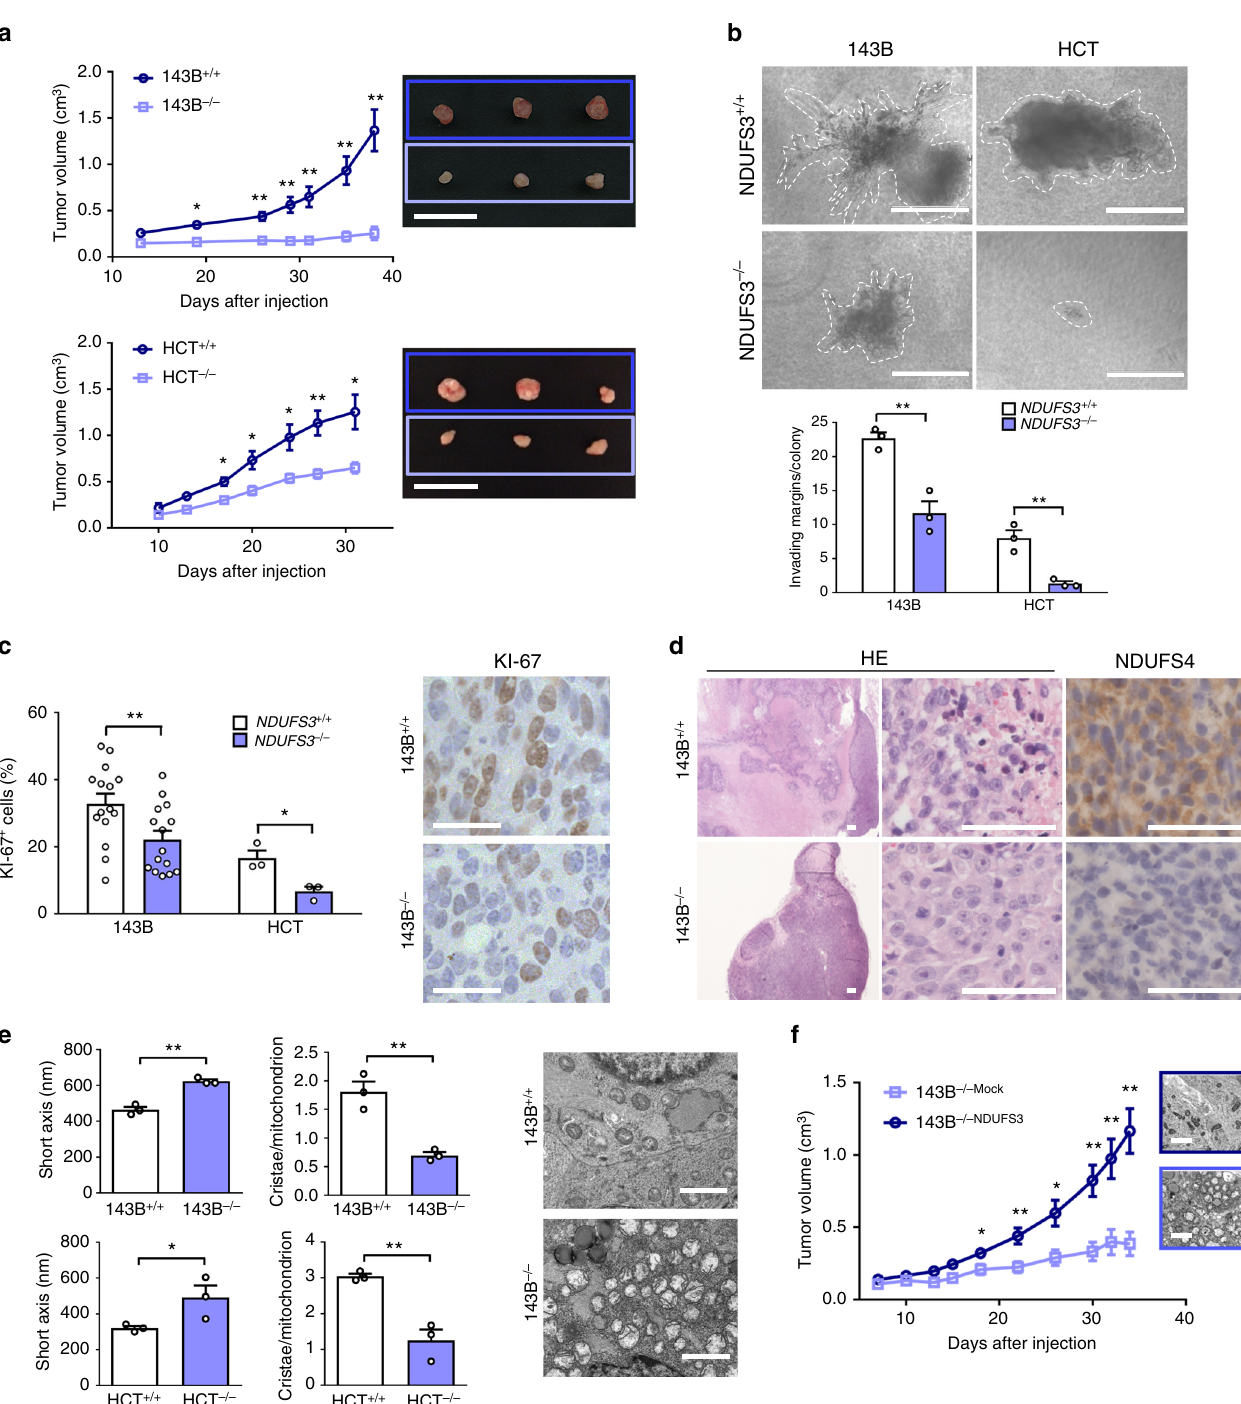
(143B − / − NDUFS3 ), under the control of a transactivator negatively regulated by doxycycline (Dox) (Supplementary Fig. 4a). By using Dox doses which did not affect CI assembly, a complete loss of the enzyme was observed after 9 days of treatment (Supplementary Fig. 4b). Moreover, at doses which do not impact tumor growth or mtDNA-encoded protein levels (Supplementary Fig. 4c – e), Dox-mediated induction of CI loss caused growth arrest in 85.7% of 143B − / − NDUFS3 proliferating tumors, decreased KI-67 proliferative index and resulted in sig- ni fi cantly prolonged survival of the animals (Fig. 2a, b, Supple- mentary Fig. 5). CI-depleted tumors showed clear-cut negative NATURE COMMUNICATIONS| (2019) 10:903